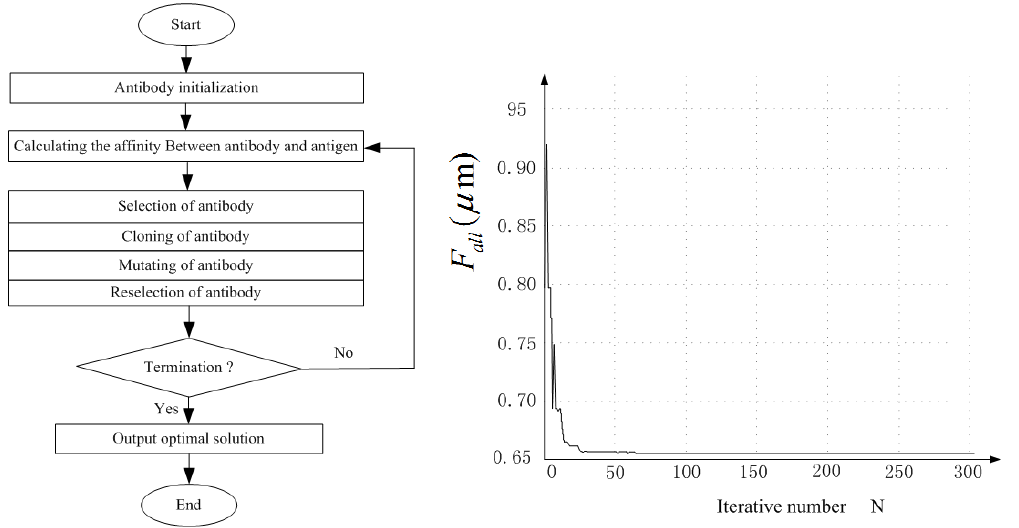
Figure 6. The flowchart and the interactions process of AICSA